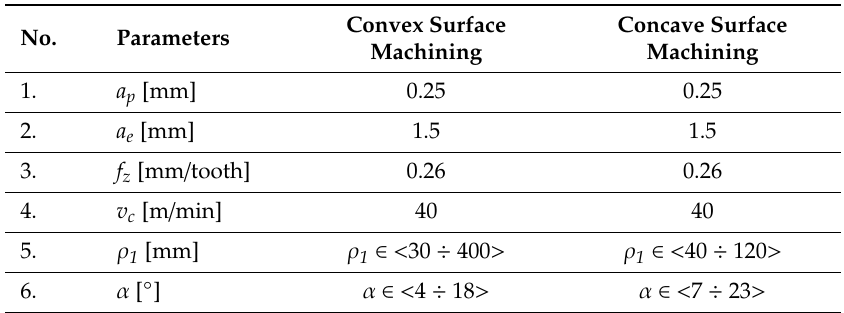
Table 4. Machining